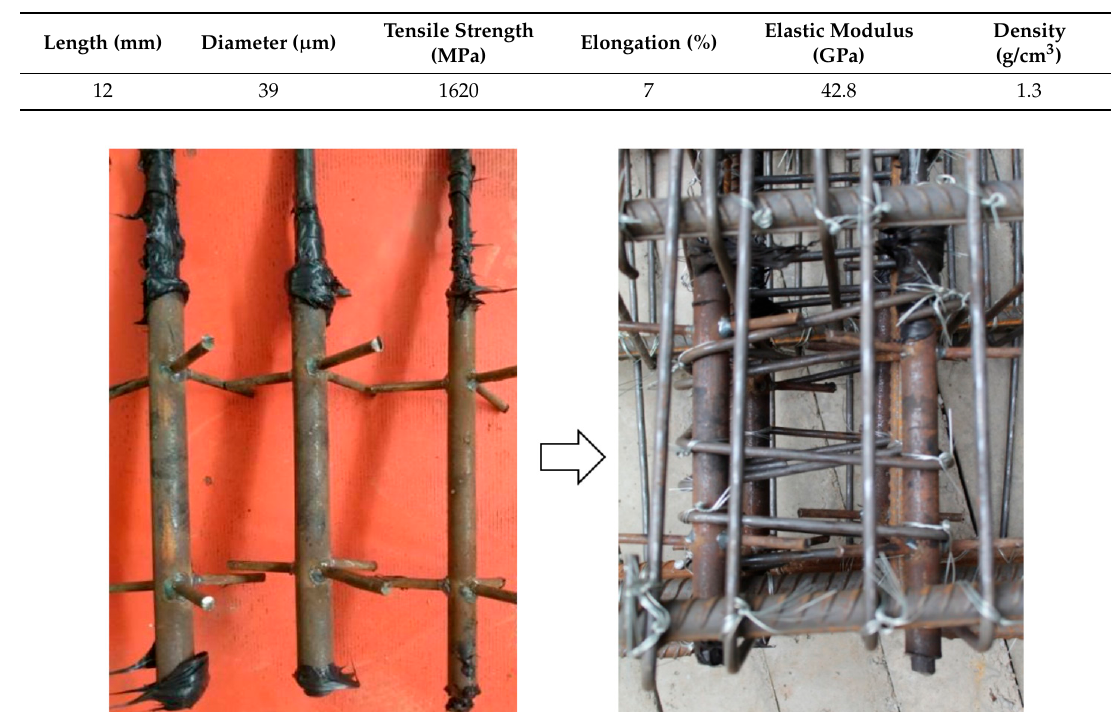
Table 2. Specific performance indexes of PVA fiber.